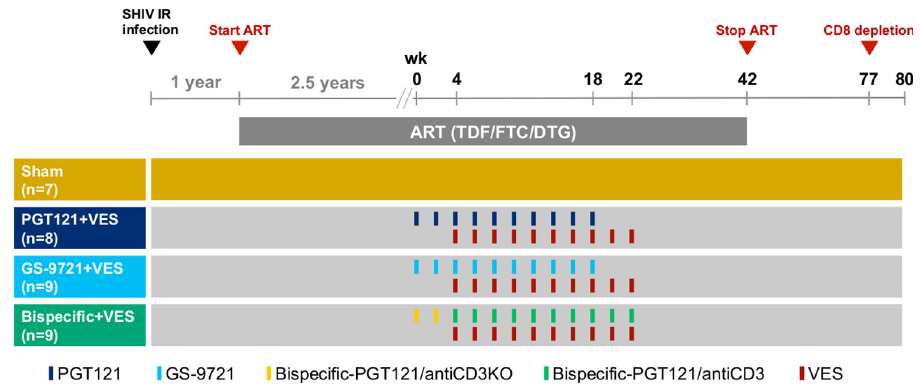
Fig 1. Schematic representation of study design. 33 rhesus macaques were infected interrectally with SHIV-SF162P3 and after 1 year of infection initiated on ART. Following 2.5 years of ART, animals were assigned to Sham (Group 1, n = 7), PGT121 and VES (Group 2, n = 8), GS-9721 and VES (Group 3, n = 9) or bispecific-PGT121/anti-CD3 and VES (Group 4, n = 9). Animals in Group 2 and 3 received 10 biweekly doses of antibody and VES with the